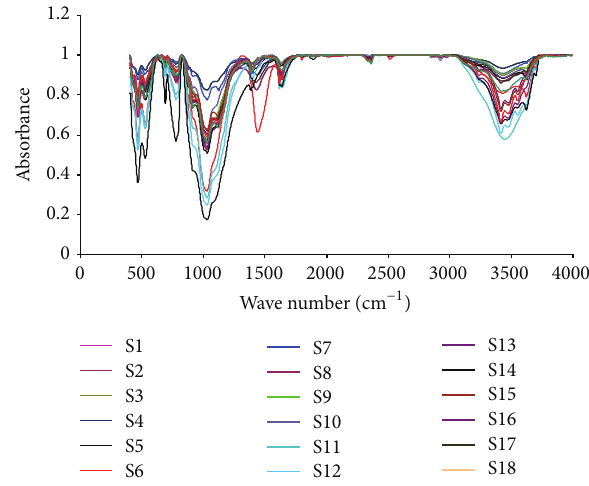
Figure 1: Infrared spectra of eighteen soil samples (S1 to S18).